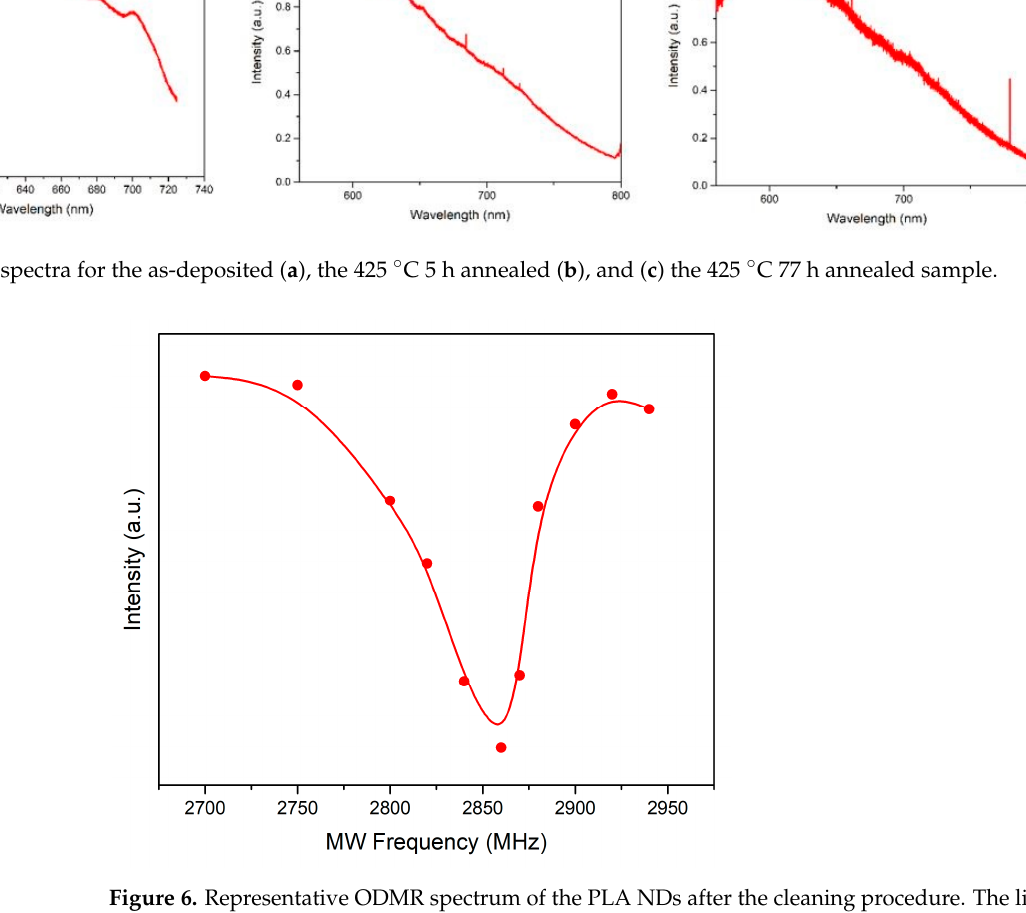
Figure 6. Representative ODMR spectrum of the PLA NDs after the cleaning procedure. The line is a guide for the eye.